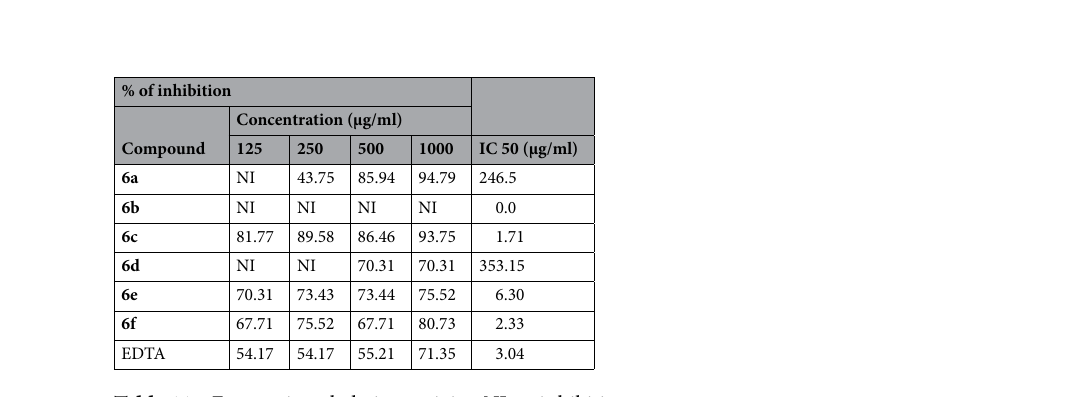
Table 11. Ferrous ion chelating activity. NI no inhibition.